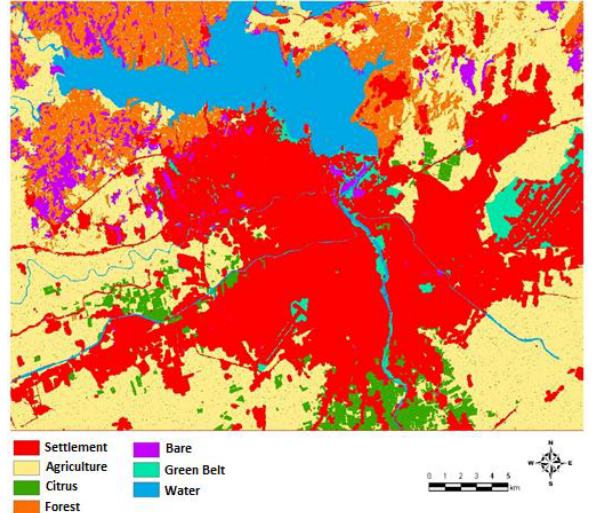
Figure 5. 2023 SLEUTH model prediction map.